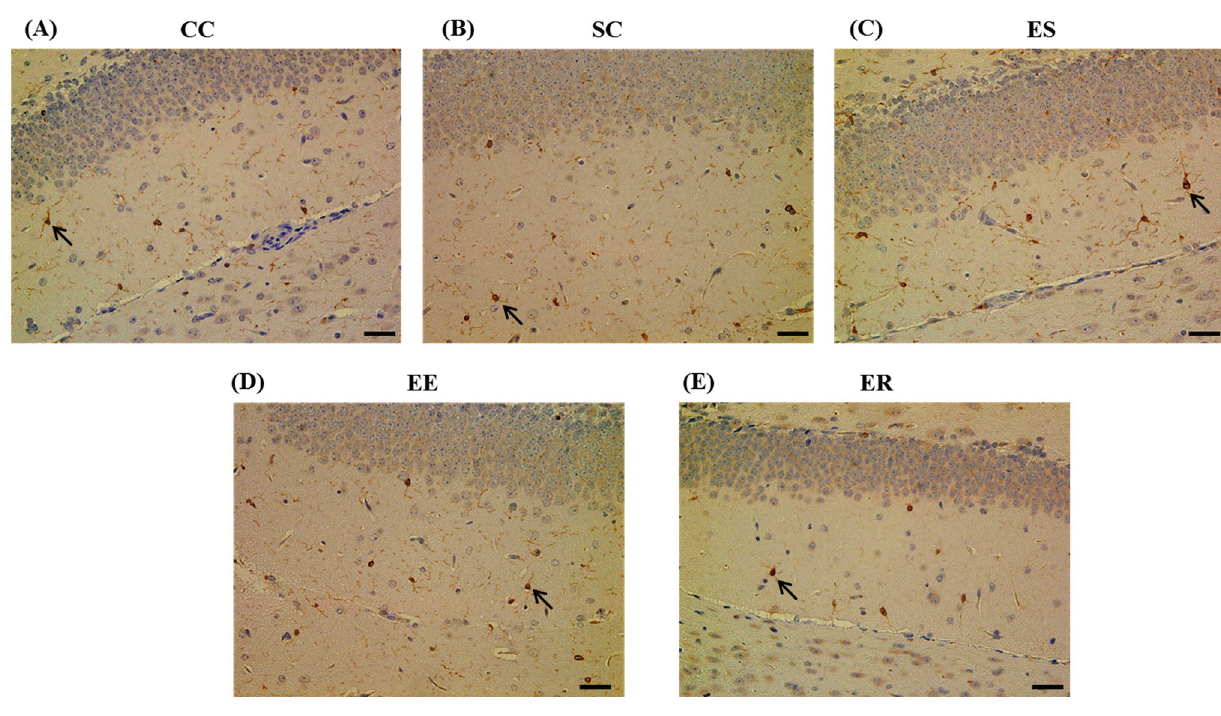
Figure 5. Representative digital photomicrographs of microglia marker Iba1-immunostained sections taken from the hippocampus in ( A ) CC, ( B ) SC, ( C ) EE, ( D ) ES, and ( E ) ER groups of 7-week-old male mice. (Scale bar = 25 μ m). Arrow indicates the activated